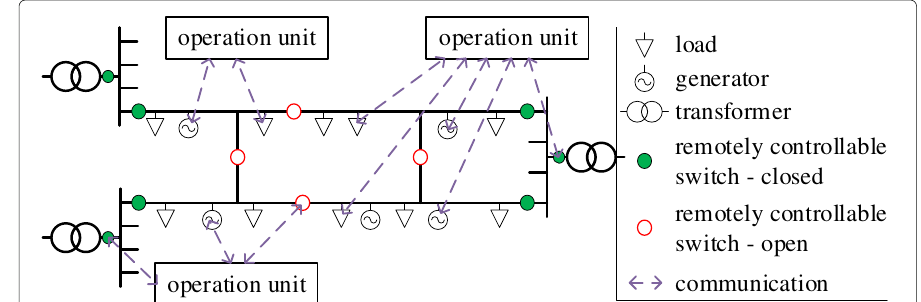
Fig. 2 Decentralized operation architecture for the operation of a distribution grid. Each of the three decentralized operation units operates the grid area of a primary substation. Source: Adapted from Drayer (2018)